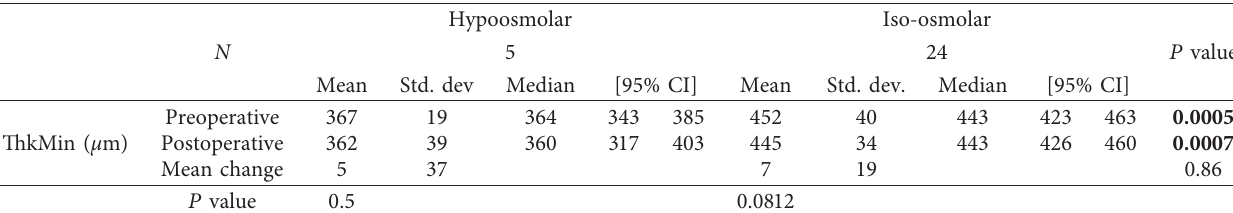
Table 3: Corneal thickness changes between hypoosmolar and iso-osmolar riboflavin